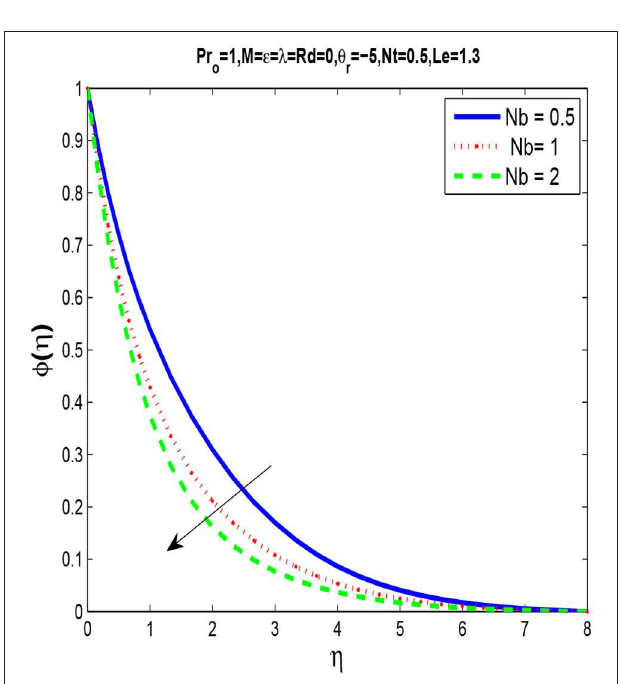
FIGURE 6 | The concentration profile φ ( η ) for different N b ( For Case B).